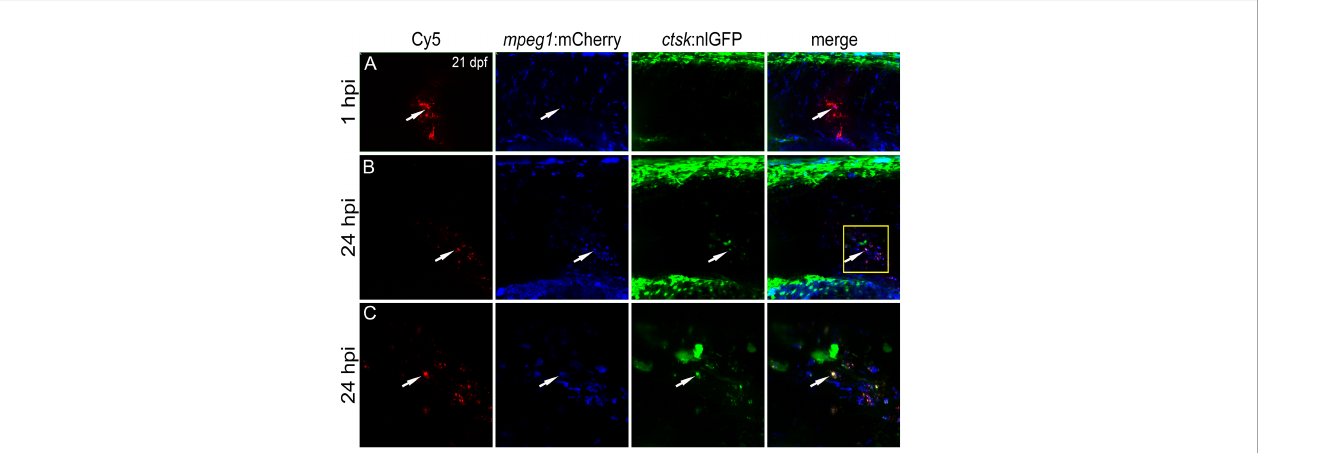
FIGURE 5 CaP nanoparticles are internalized by Rankl-induced macrophages that subsequently differentiate into osteoclasts. Cy5-labelled CaP nanoparticles were injected into trunk muscle of mpeg1 :mCherry/ ctsk :nlGFP/ rankl : HSE: CFP transgenic medaka larvae at 21 dpf after a heat shock had been applied at 20 dpf to induce Rankl expression. (A) Lateral view of trunk region showing Cy5-labelled nanoparticles, mpeg1 :mCherry positive macrophages, ctsk :nlGFP positive osteoclasts and merged image at 1 hpi. (B) Same larva at 24 hpi. (C) High magni fi cation view of region indicated as box in (B) Colocalization of Cy5, mCherry and/or nlGFP signals is indicated by white arrowheads. 5 out of 5 analyzed embryos showed this